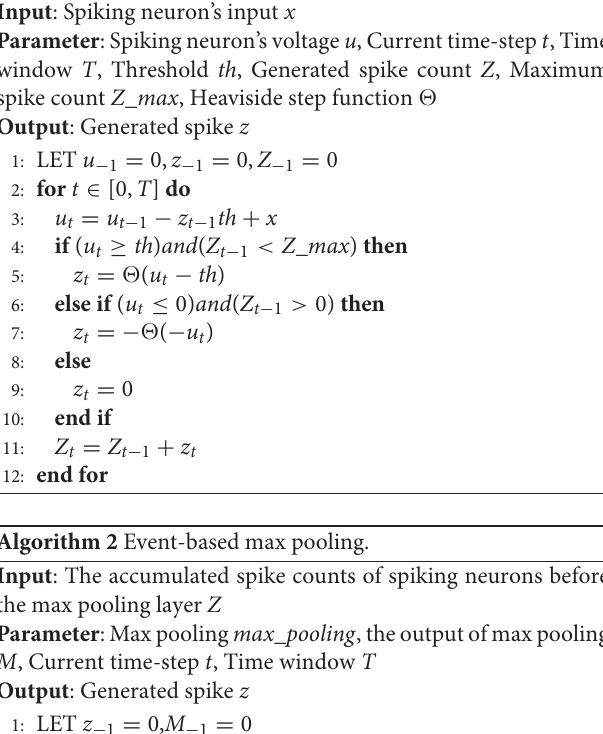
Algorithm 1 The spiking neuronal model.